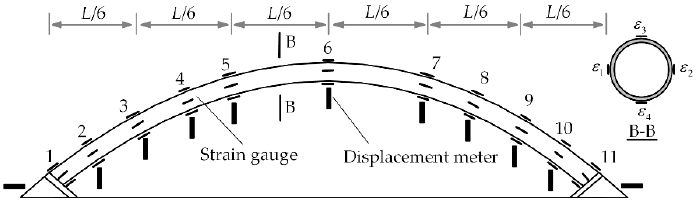
Figure 2. The measuring scheme of arch-A.